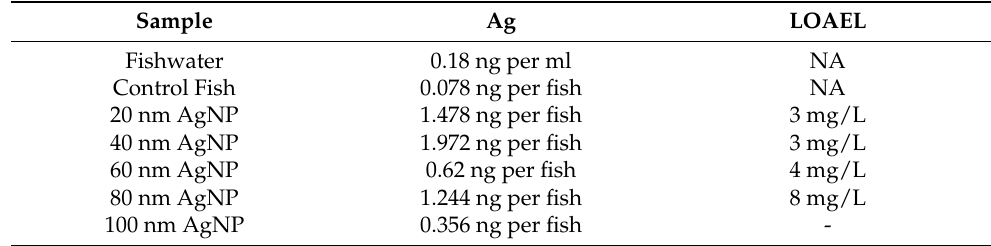
Table 2. Summary of Ag uptake into zebrafish and toxicity for AgNPs used to assess risk to zebrafish. Sample